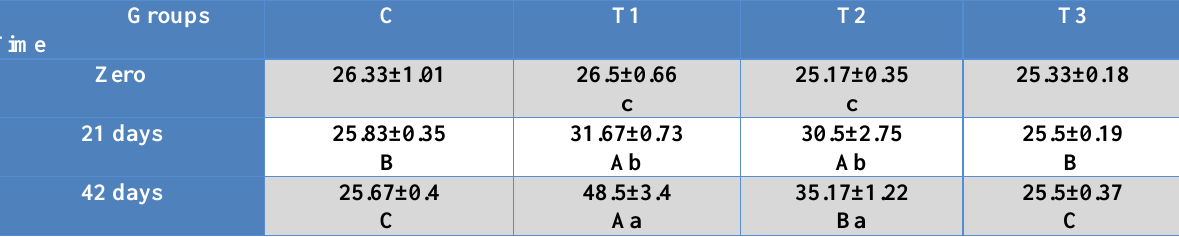
Table, 2: Effect of pomegranate seed oil (PSO), on blood urea nitrogen (BUN) concentration (mg/dl) in methionine treated adult female